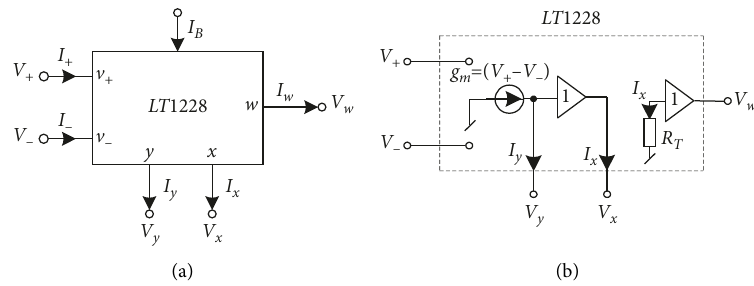
Figure 1: LT1228. (a) Electrical symbol. (b) Equivalent circuit.